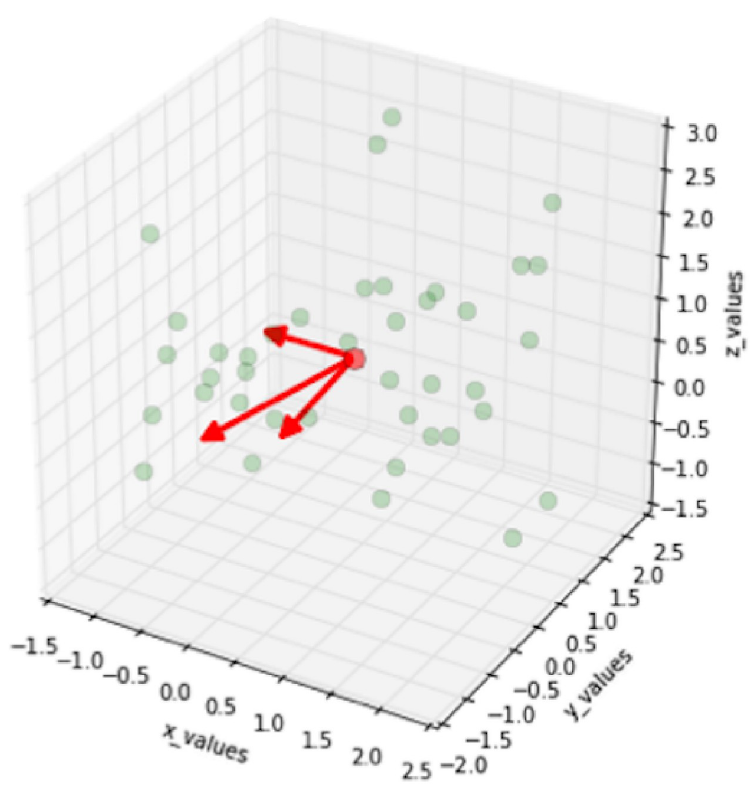
Fig 20. Eigenvalues and eigenvectors [69].